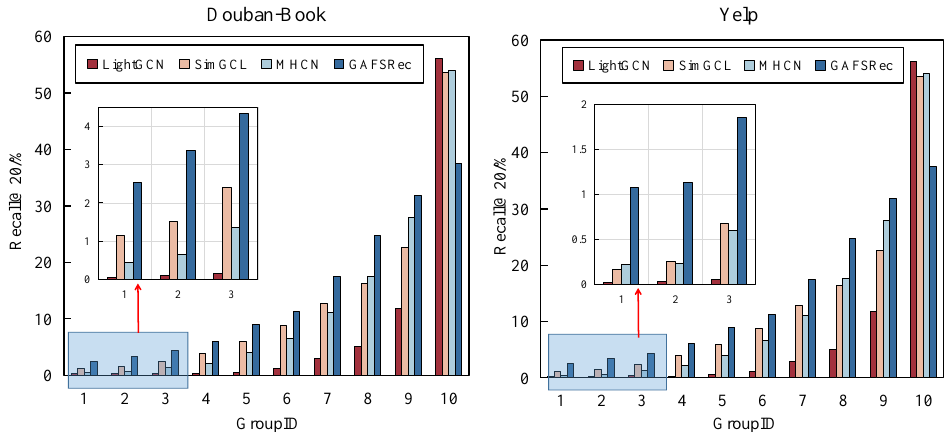
Figure 4. The ability to promote long-tail items.